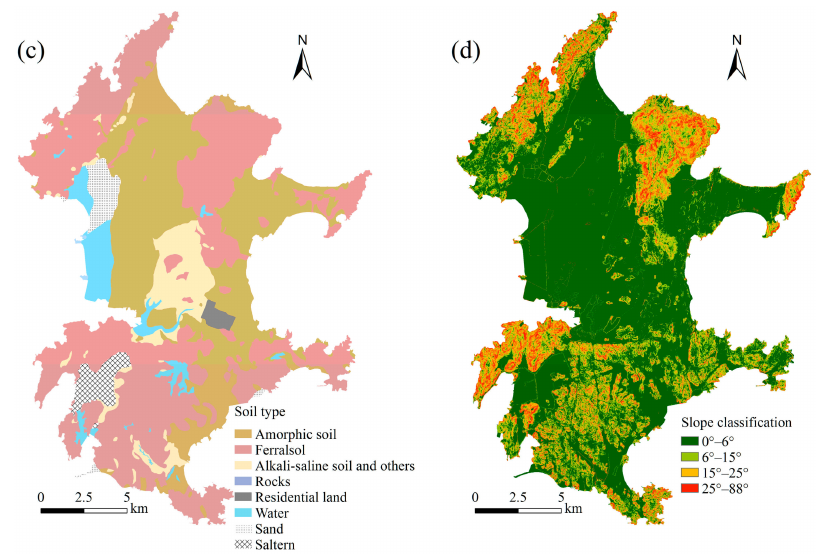
Figure 1. ( a ) The study area and location of meteorological and rainfall stations; ( b ) Spatial distribution of land use; ( c ) Spatial distribution of soil types; and ( d ) Map of slope